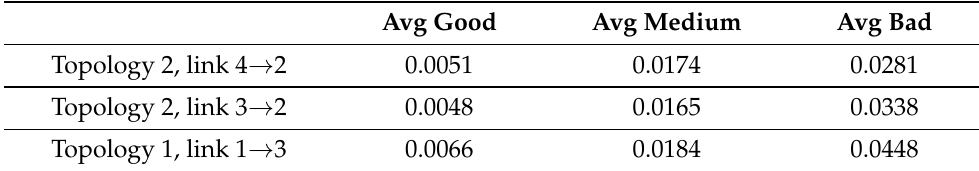
Table 2. Average BER values, three-state HMM.